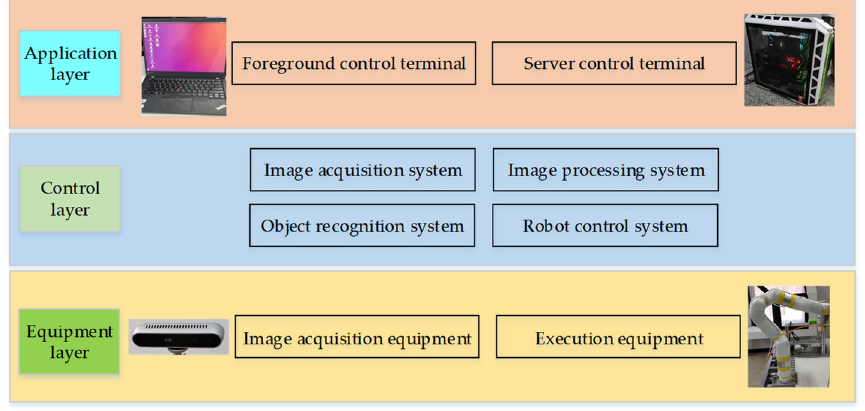
Figure 1. Robot object detection system.